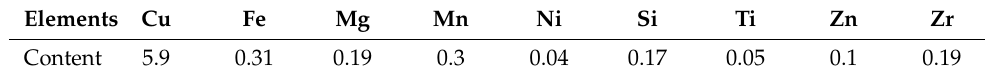
Table 1. Composition of 2519A aluminum alloy (Mass fraction/%).